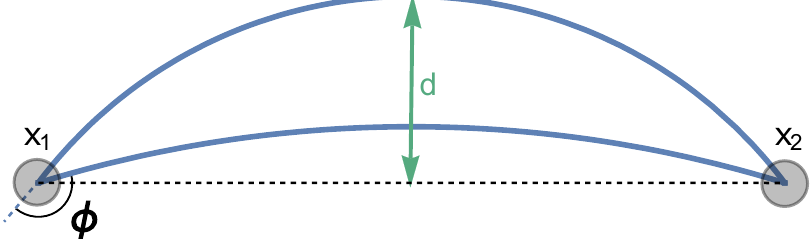
Figure 6 . The 2-cusp correlator. For regularisation we cut an (cid:15) -ball around each of the cusps. The con(cid:12)guration is parameterised by the external angle (cid:30) . The result does not depend on d (or equivalently (cid:31) in (3.3)) and is only a function of x 12 = j x 1 (cid:0) x 2 j ; (cid:30); (cid:1) and the regulator (cid:15)